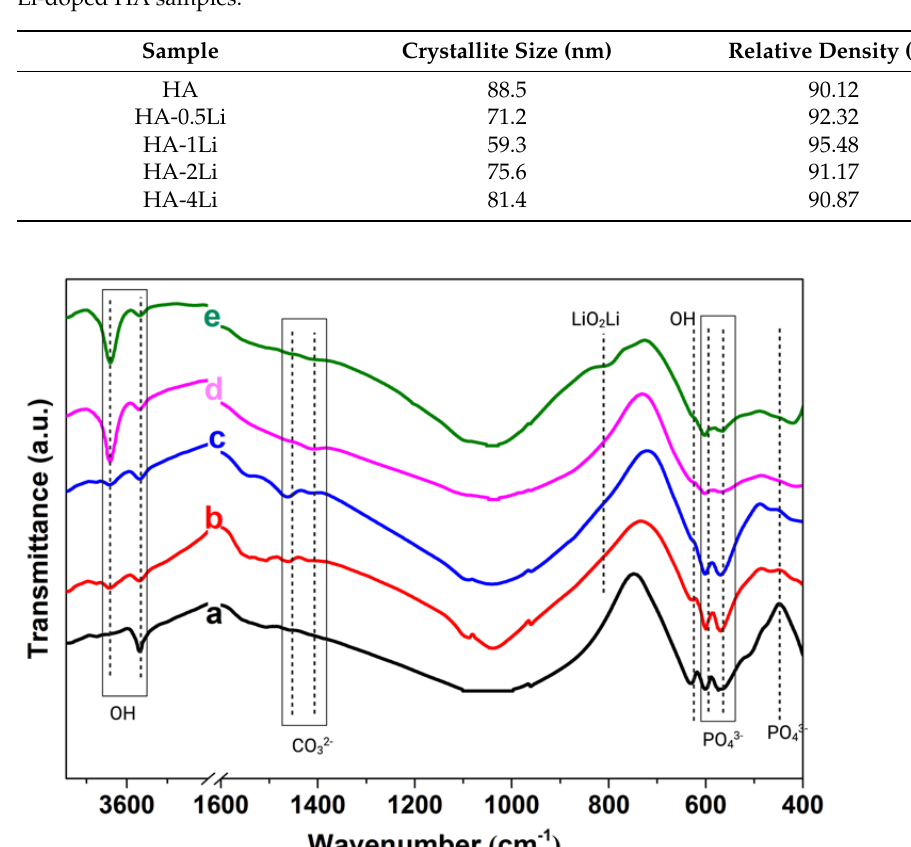
Figure 1. XRD pattern of: ( a ) HA. ( b ) HA-0.5Li. ( c ) HA-1Li. ( d ) HA-2Li. ( e ) HA-4Li sintered at 1250 °C.